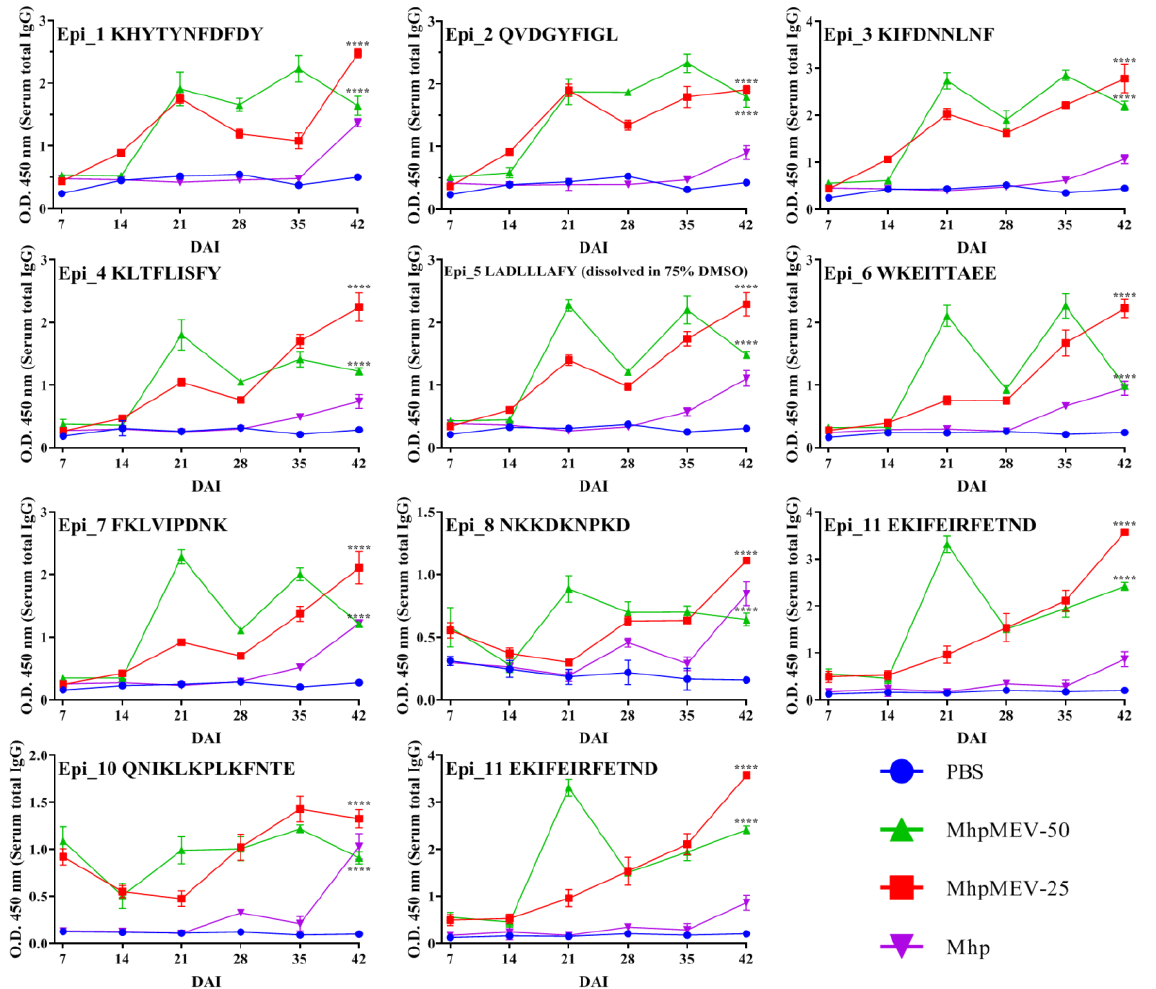
Figure 7. The ELISA results against 11 synthetic epitopes in mouse immune experiment, and the epitope sequences are shown in the top left corner of each figure. Serum antibodies from the MhpMEV-25 group showed higher levels when compared to the MhpMEV-50 group against the 11 synthetic epitopes ( p < 0.0001), except for QVDGYFIGL at 42 d (ns). The serum antibodies from the Mhp group could also detect all of the synthetic epitopes when compared to the PBS group at 42 d ( p < 0.0001). The symbol **** indicates a statistical difference between the MhpMEV-25 or MhpMEV-50 group and the PBS group in the figures. All data are presented as means ± standard deviation; unpaired t test with Holm – Sidak adjustment was used for significance analysis, **** p < 0.0001.